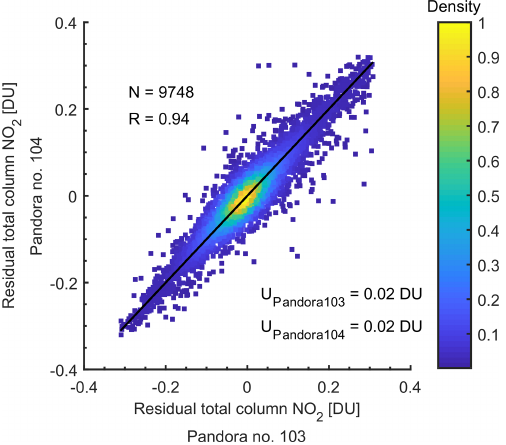
Figure 10. Scatter plot of residual total column NO 2 measured by Pandora nos. 103 and 104 (December 2017 to June 2019), colour- coded by the normalized density of the points. The black line is the one-to-one